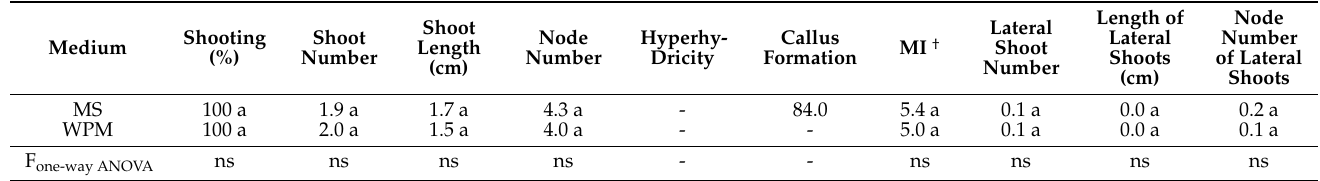
Table 5. Effect of two different media, MS and McCown woody plant medium (WPM) without hormones, on the elimination of hyperhydration during the multiplication phase of Sideritis raeseri subsp. attica .